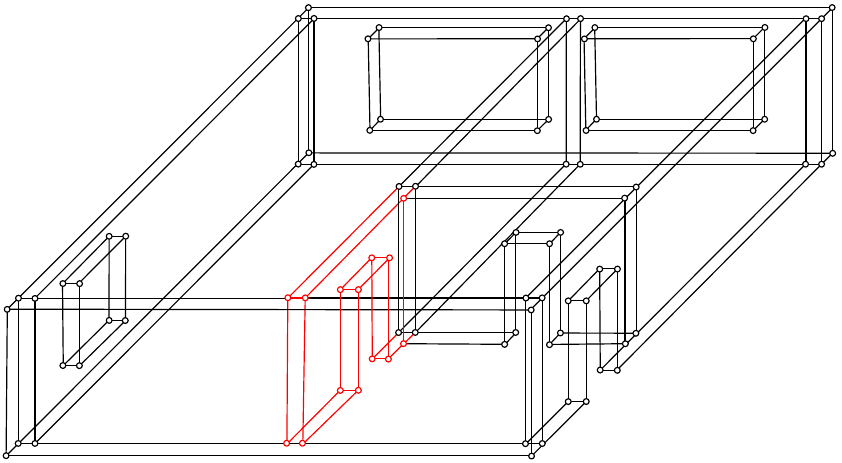
Figure 5. Modification of the linear complex in Figure 2.